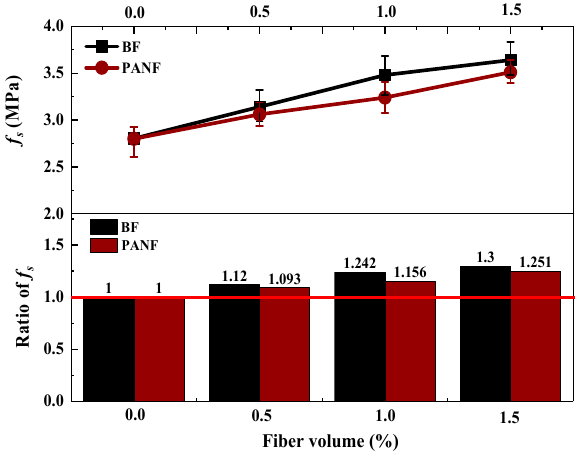
Figure 12. E ff ect of BF and PANF on shear strength of Figure 12. Effect of BF and PANF on shear strength of LWACs.